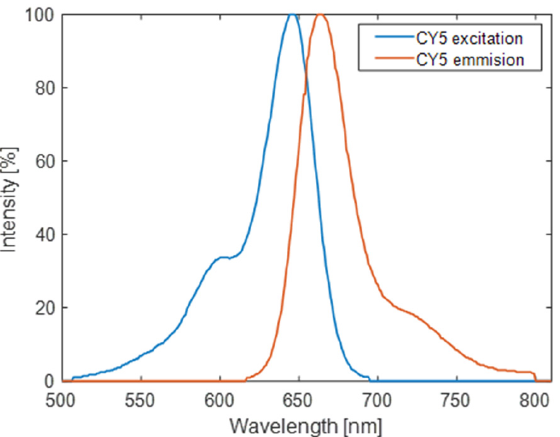
Figure 3. Excitation and emission spectra of cyanine-5 fluorophore. Spectral data obtained from Thermofisher SpectraViewer [75].